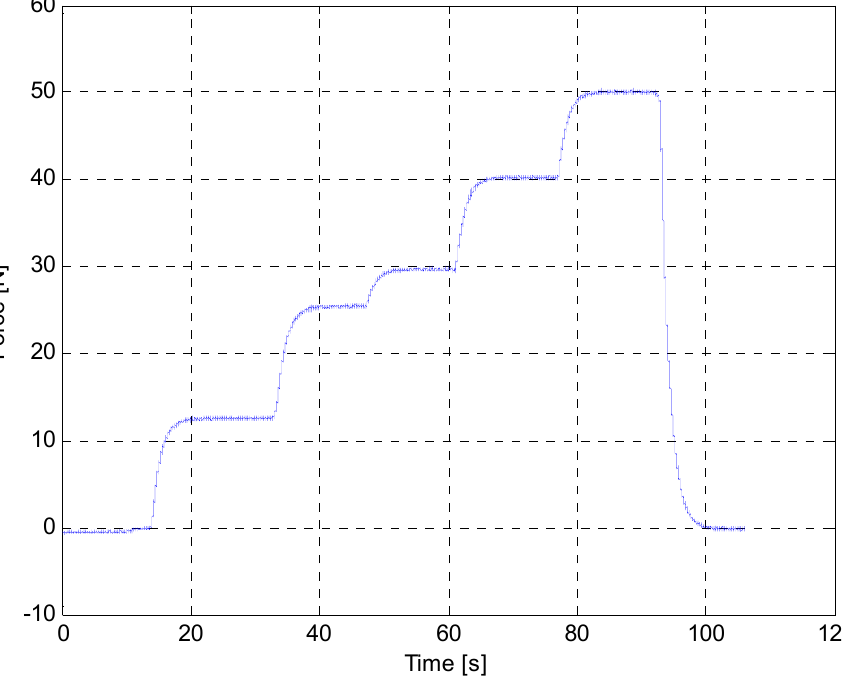
Figure 8. Measurements obtained with the force sensor of the instrumented prodder.